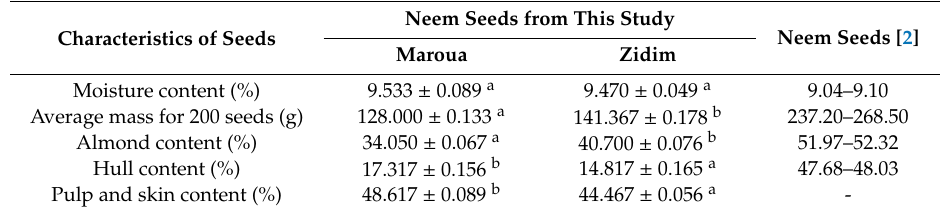
Table 1. Physicochemical characteristics of neem seeds studied compared to those of Senegalese neem